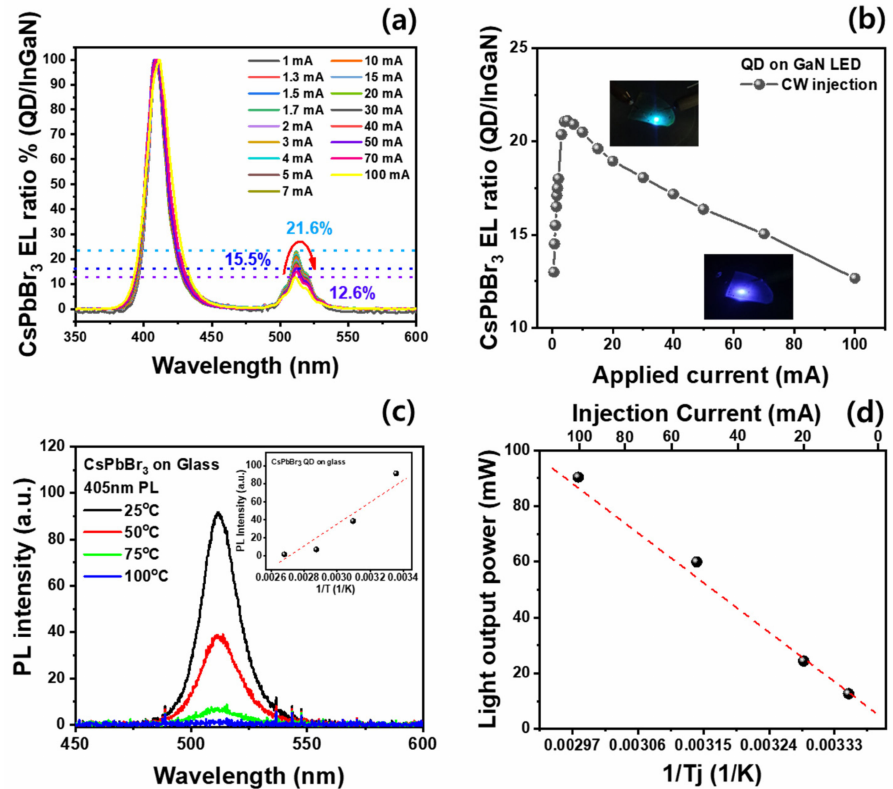
Figure 4. ( a ) Normalized EL spectra of the hybrid LEDs with CsPbBr 3 QDs under different injection currents. ( b ) EL intensity ratio of the green to violet emissions in hybrid LEDs. ( c ) Temperature- dependent PL spectra of the CsPbBr 3 QDs on glass substrate. The inset is the PL intensity of the CsPbBr 3 QDs as a function of reciprocal temperature. ( d ) The light output power of the hybrid LEDs as a function of the reciprocal junction temperature and injection